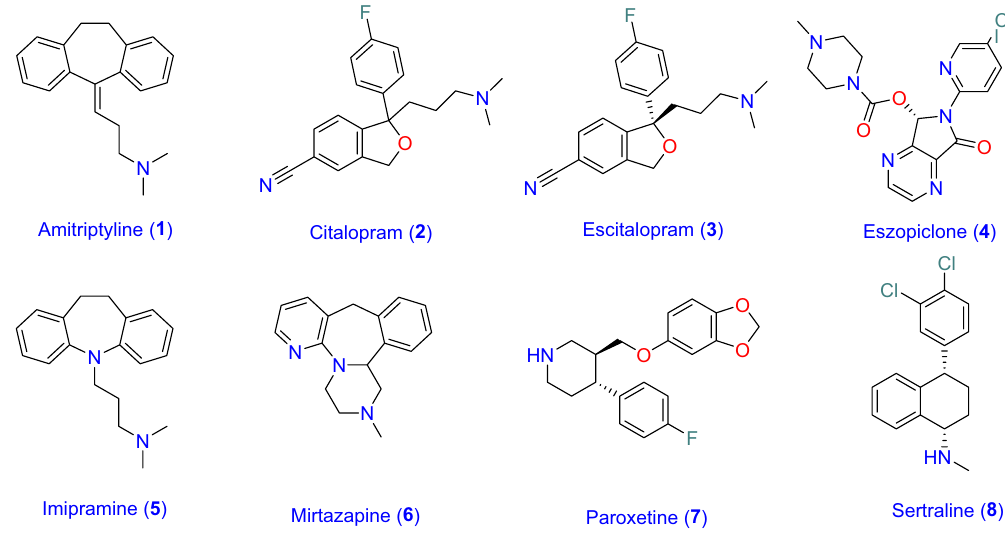
Figure 1. FDA-approved antidepressants with potential antiviral